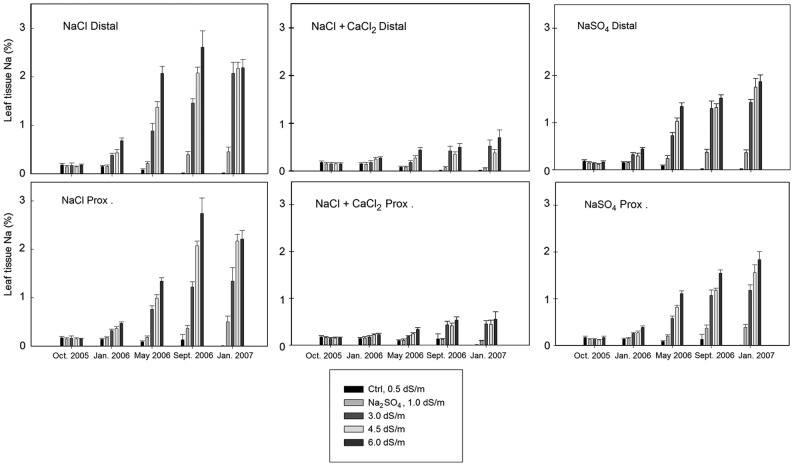
Na+ ion concentration in the distal and proximal ends of the leaf tips from all treatment groups (excluding the CaCl2 treatments). At every harvest the greatest % Na+ in leaf tissues (distal and proximal) were detected in the 6.0 dS m−1 group in NaCl treatment. Over time, the % Na tissue concentration increased in all salinity concentrations across all ion treatments. The per cent concentration did not differ greatly between distal and proximal ends of the leaf for any treatment combination. The distal and proximal leaf tissues harvested from plants treated with NaCl had 2–3 times greater Na+ when compared with the NaCl + CaCl2 group, and 25 % greater than the NaSO4 group.